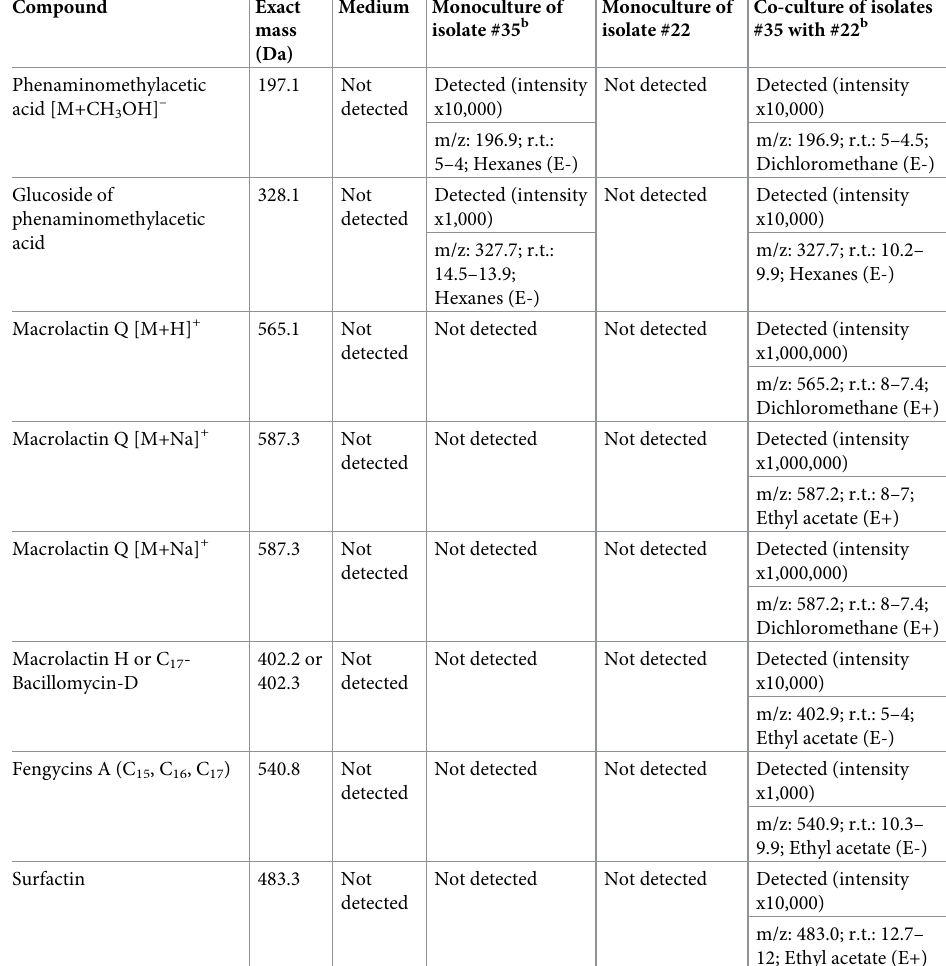
Table 3. Detected LC-MS peaks matching chemically characterized compounds, described in the literature as sec- ondary metabolites produced by species of the Bacillus amyloliquefaciens group that includes Bacillus siamensis a .